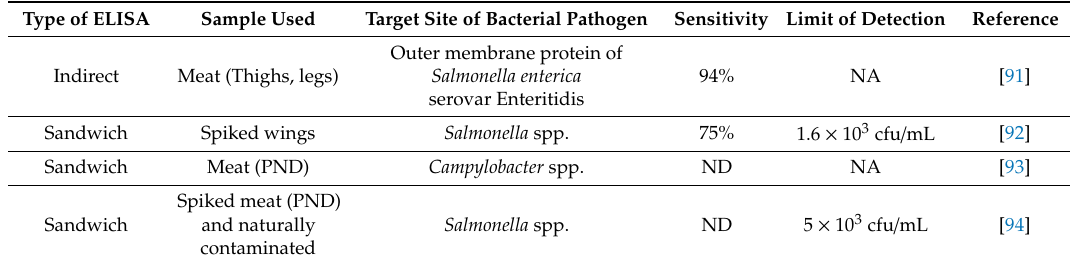
Table 6. ELISA-based approaches used for the detection of chicken-borne